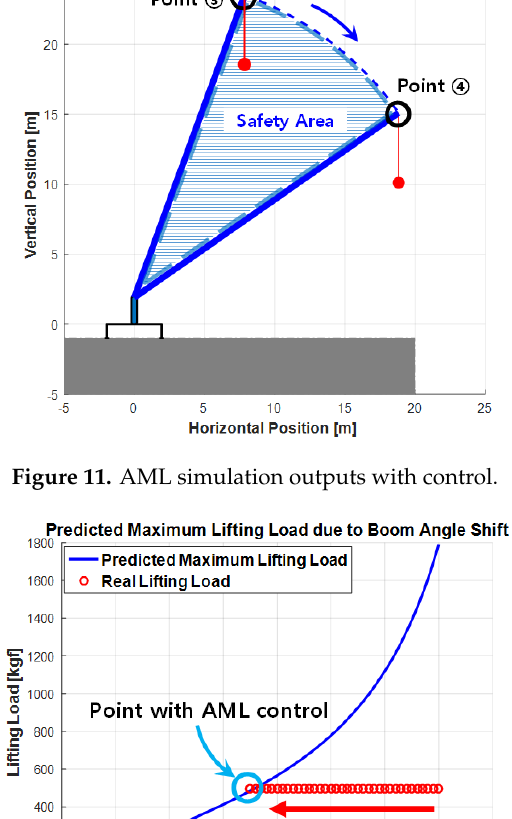
Figure 11. AML simulation outputs with control.